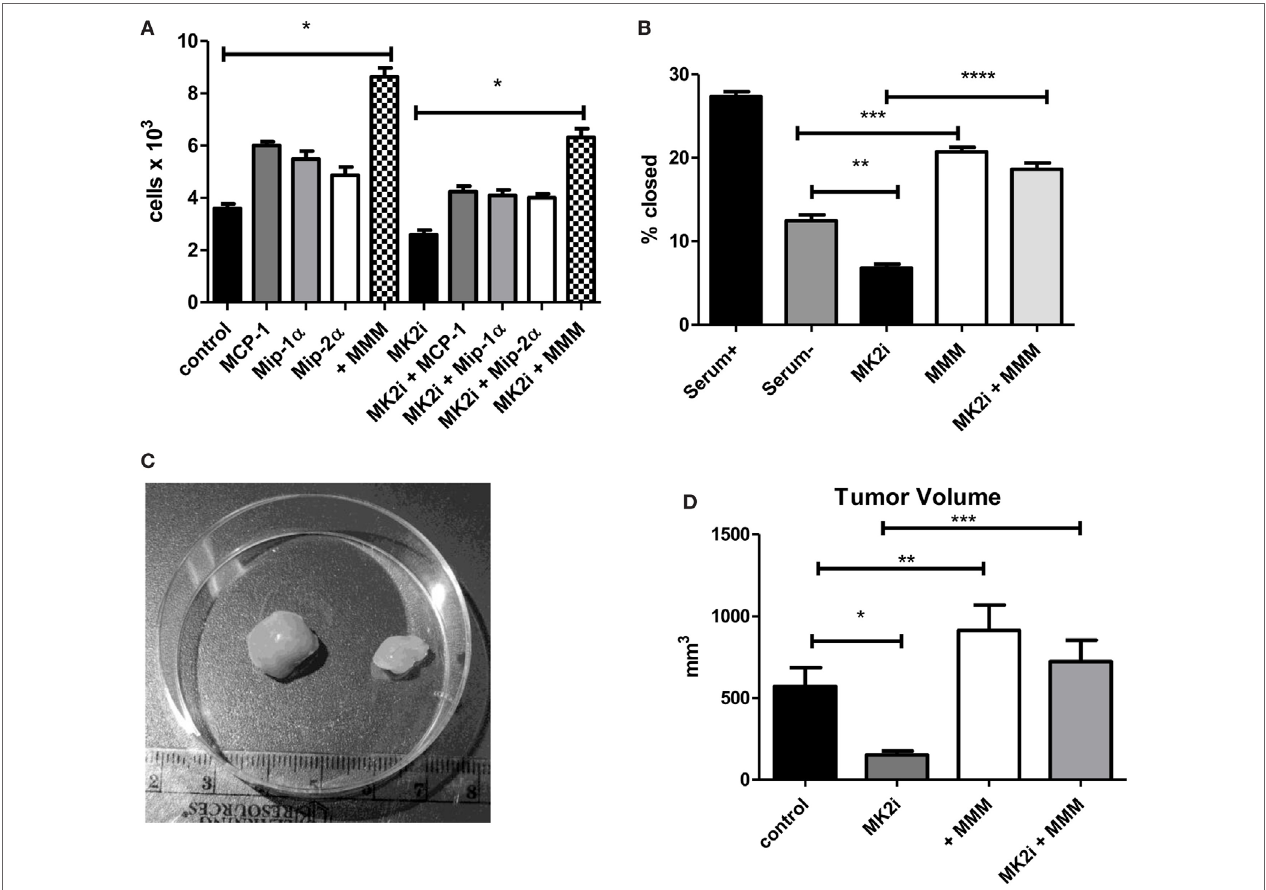
FigUre 2 | MCP-1, Mip-1 α , and Mip-2 α induce tumor cell proliferation, invasion, and in vivo tumor growth in an MK2-dependent mechanism. CT26 cells in culture treated with MCP-1, Mip-1 α , and Mip-2 α (MMM) show increased (a) cell proliferation measured 4 days after treatment with chemokines and (B) invasion through Matrigel after 12 h, which is decreased upon MK2 inhibitor treatment. In vivo , (c) MK2 inhibition decreased tumor growth and (D) addition of MMM to tumors treated with MK2 inhibitor restores tumor growth by day 13. N = 8 for cultured tumor cells and 7–8 for tumors from multiple experiments, *, **, and *** p ≤